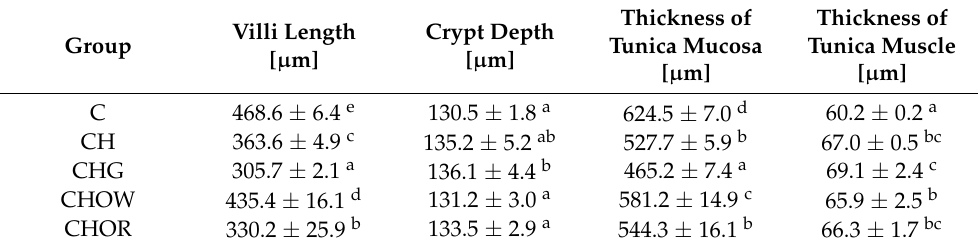
Table 4. Influence of lyophilized garlic, white onion, and red onion additions on performance (body weight gain, FER, and somatic index of liver (SI-L)) in rats fed control and cholesterol-containing (1% of cholesterol) diets during the 28 day experiment.